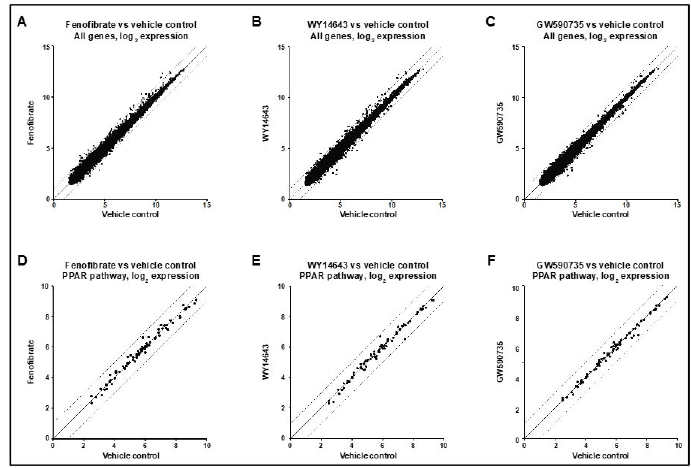
Figure 4. Gene expression is unchanged in whole retinas isolated from mice treated with intrav- itreous fenofibrate or known PPAR α pathway activators. The vitreous cavities of both eyes of three-month-old male mice were injected with fenofibrate, GW590735, WY14643 or a vehicle control ( n = 3). Whole retinas were harvested 24 h later and RNA was isolated, amplified and analyzed by microarray. ( A – C ) Log2 expression levels for all probes in the drug-treated vs. control animals are shown for fenofibrate, GW590735, and WY14643. ( D – F ) The subset of probes corresponding to genes belonging to the PPAR pathway (as annotated in KEGG) are shown. The solid line represents equal expression in the two groups, while the dashed lines represent a 2-fold difference in gene